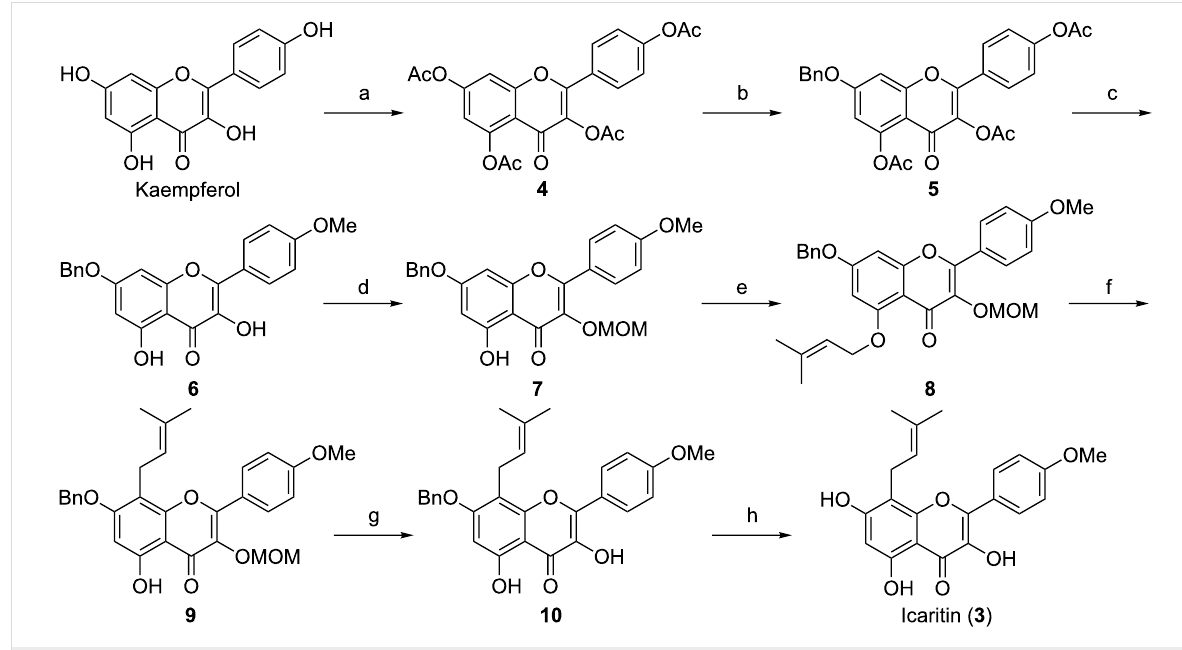
of the long synthetic routes, tedious work-up and harsh reaction conditions, an alternative access to icariin ( 1 ) and related com- pounds is demanded for large-scale production and practical